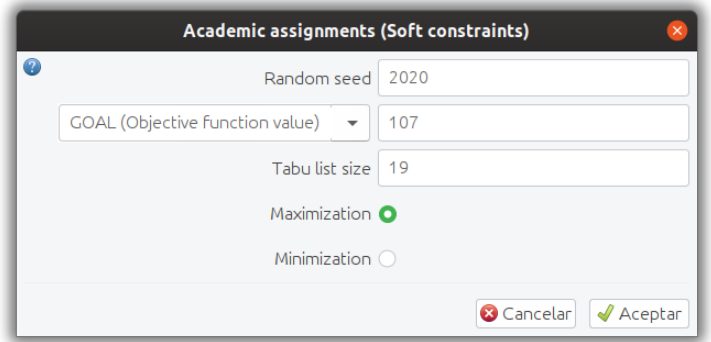
Figure 11. A configuration of the TS-PAC parameters for the ACA phase (soft